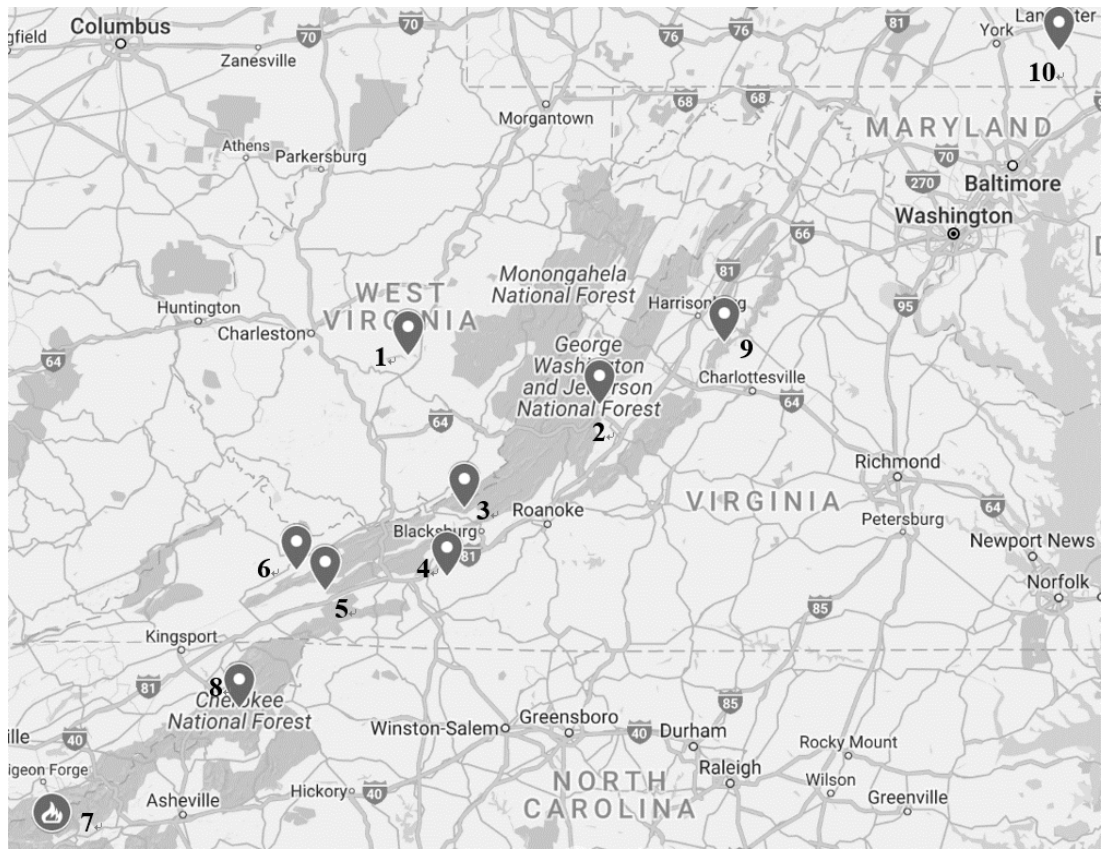
Figure 1. Map of locations of Laricobius osakensis release sites used in the study. Pins are numbered by field site. 1. Carnifex, WV; 2. Goshen, VA; 3. Mountain Lake, VA; 4. Powhatan Boy Scout Camp, VA; 5. Hungry Mother State Park, VA; 6. Saltville, VA; 7. Great Smoky Mountain National Park, TN; 8. Cherokee National Forest, TN; 9. Shenandoah National Park, VA; 10. Trout Run, PA.